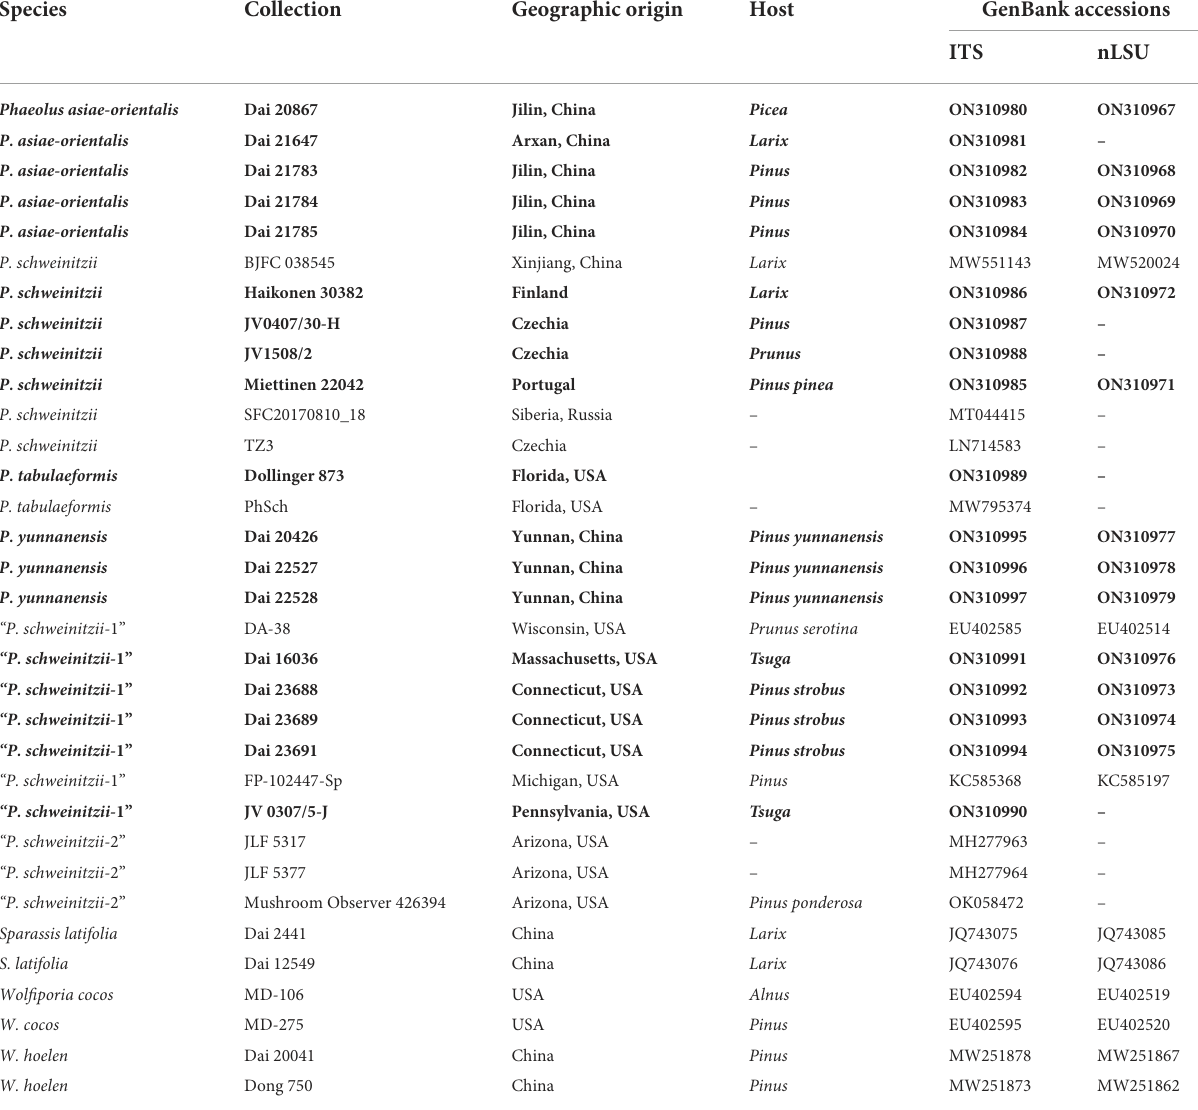
TABLE 1 Taxa information and GenBank accession numbers of the sequences used in this